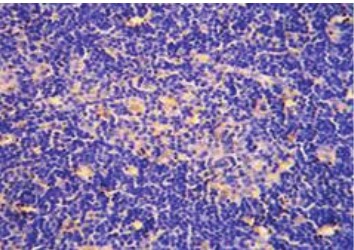
Figure 14: Model control group—21 d in OJ experiment thymus (++), Bax ×